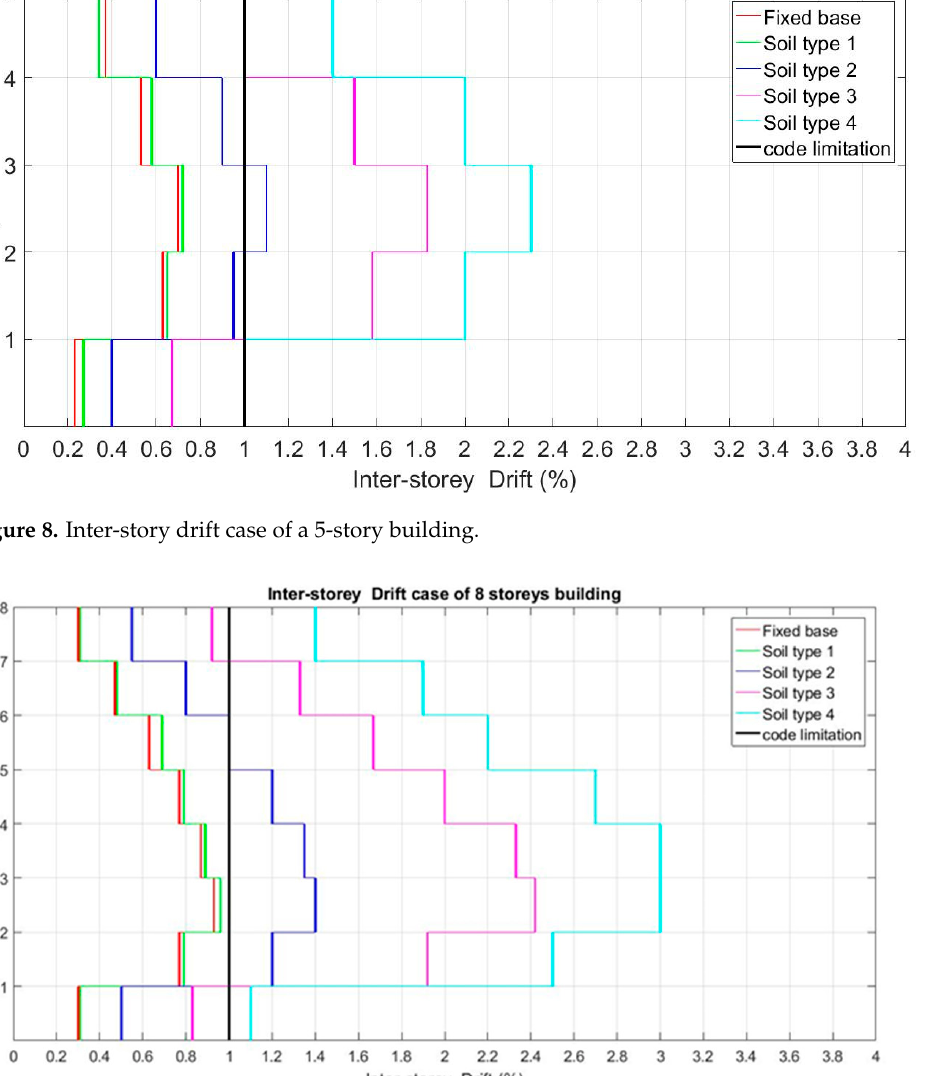
Figure 10. Inter-story drift case of a 10-story building . Comparing the results of the inter-story drifts between the fi xed base and the other soil cases, the following results of the difference between the maximum and minimum values can be observed: